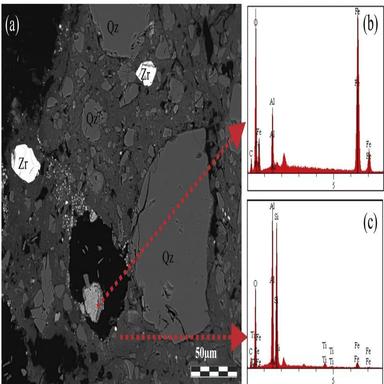
Photomicrograph obtained by MEV and chemical analysis by EDS (sample SJ.R.05/13: FLC of the lateritic profile next to FSJM): quartz grains (Qz) and zircon relicts (Zr) were observed in the image (a), immersed in a kaolinitic matrix (c), and iron oxyhydroxide concretions represented by Al-goethite (b).